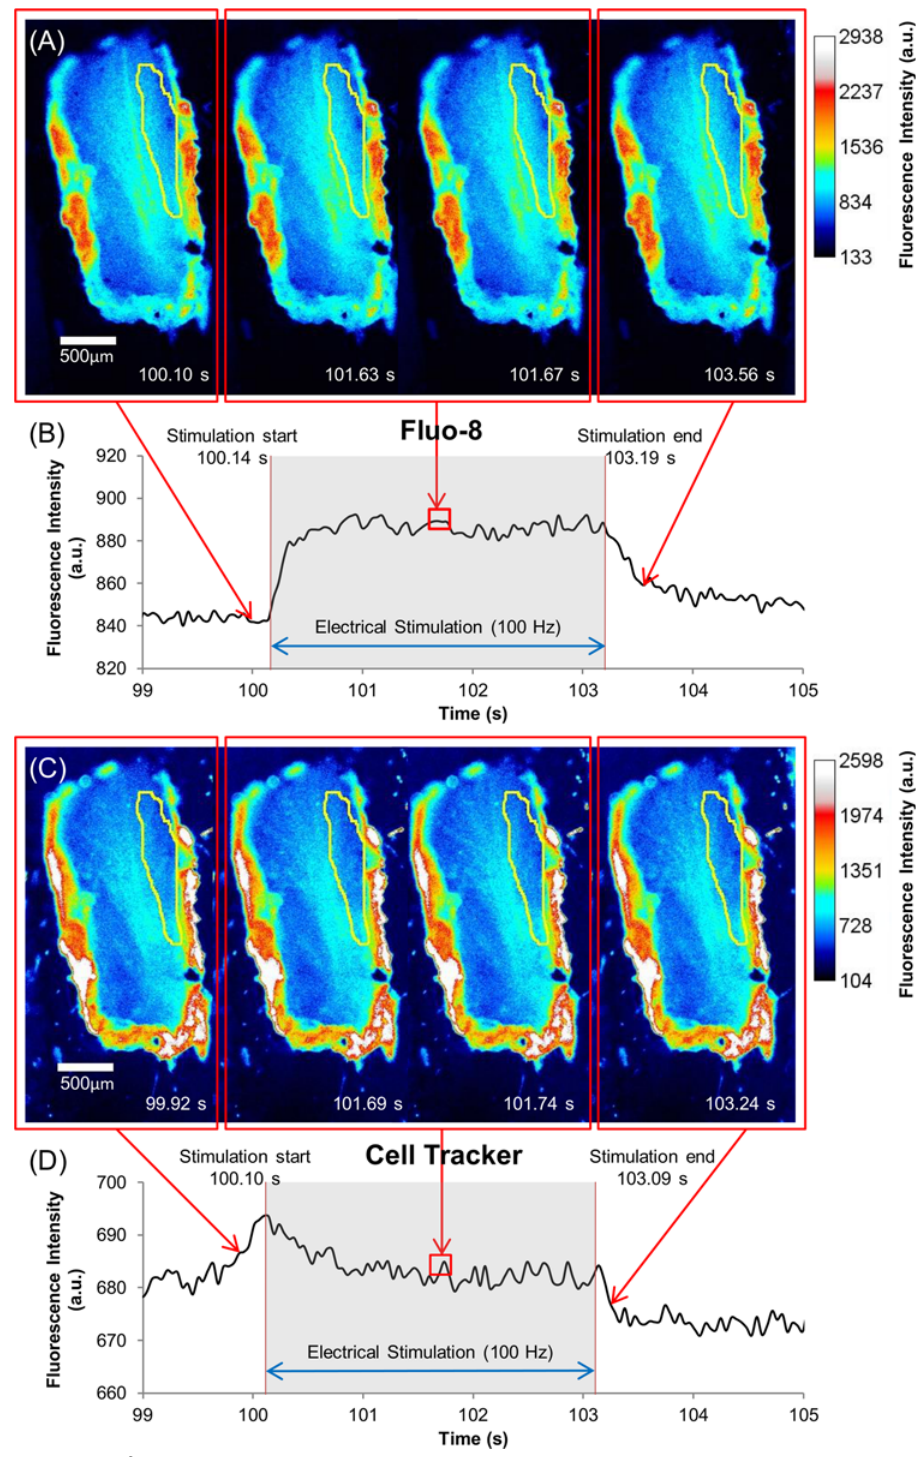
Figure 3. Ca 2+ dynamics and muscle displacement of the beetle leg muscle under electrical stimulation with multiple pulse trains (100 Hz, 10% duty cycle, 2 V) for 3 s. Pseudocolor time series images of beetle leg muscle dosed with (A) Fluo-8 (60 µ M) and (C) Cell Tracker (60 µ M) indicators. ROIs are indicated by yellow region (as also shown in S1B Fig.). The color scale is given on the right side of each image (A) or (C) respectively. Fluorescence intensity dynamics of (B) Fluo-8 and (D) Cell Tracker